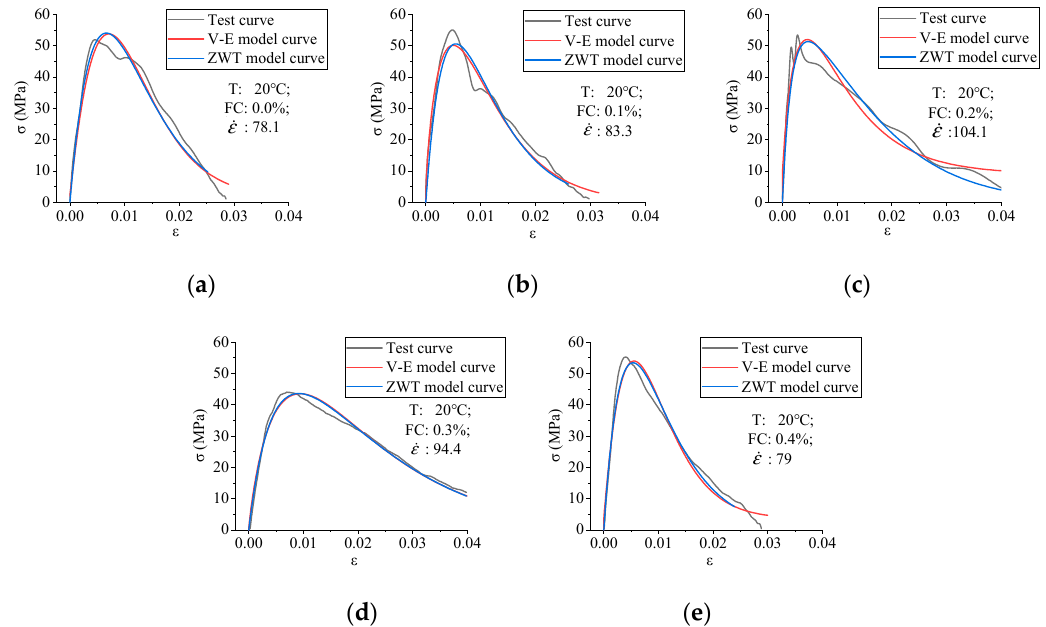
Figure 10. The comparison between test curves and fitting curves with different fiber contents (temperature: 20 °C, impact velocity: 8.8 m/s). ( a ) Fiber content: 0.0%; ( b ) fiber content: 0.1%; ( c ) fiber content: 0.2%; ( d ) fiber content: 0.3%; ( e ) and fiber content: 0.4%.